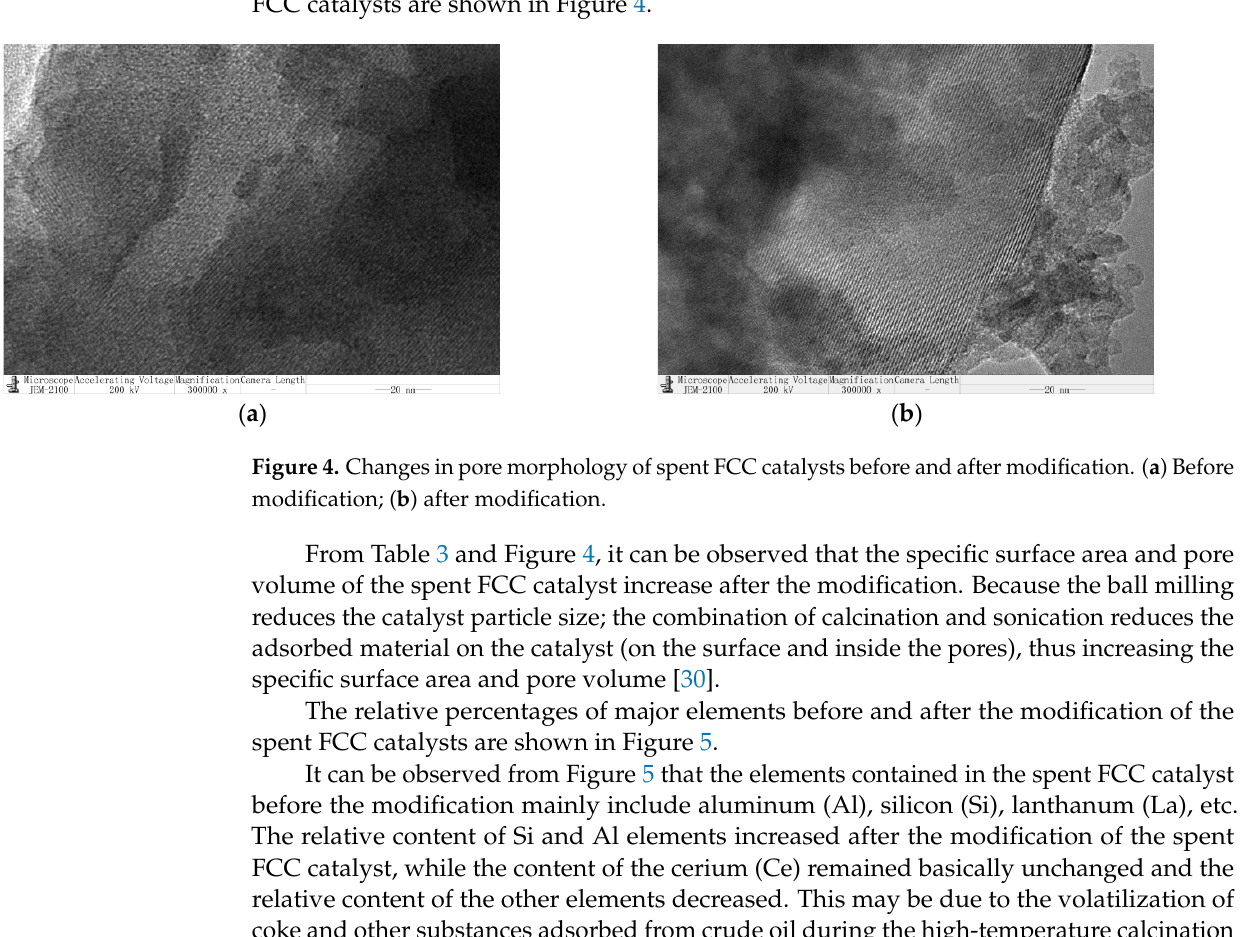
Figure 5. Relative proportions of main elements. ( a ) Before modification; ( b ) after modification.